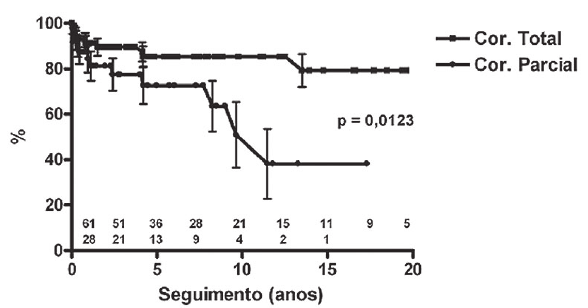
Fig. 2 - Avaliação da taxa de sobrevivência das crianças submetidas a correção total em comparação às submetidas a correções paliativas, com defeitos residuais ou com uso de próteses valvares. (Correção Parcial = paliativas, com defeitos residuais ou com próteses